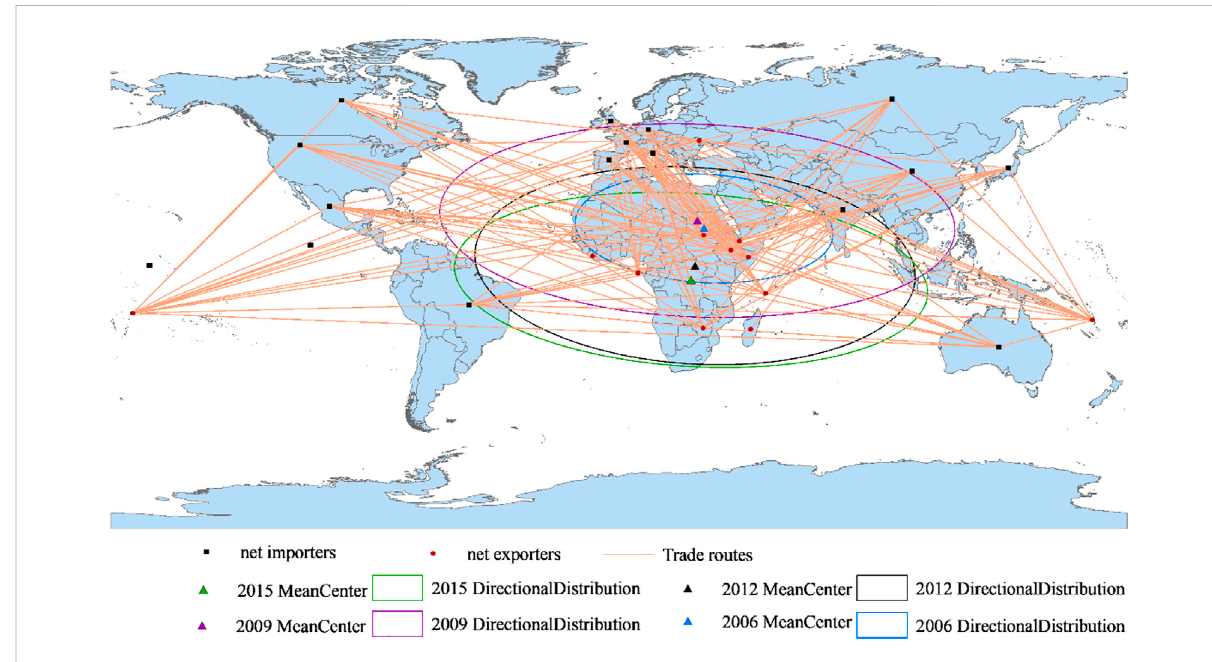
FIGURE 4 International trade routes for biodiversity risks associated with traded